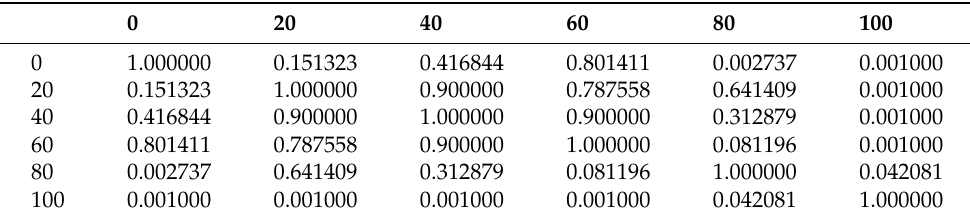
Table 5. Multiple Comparison Test (Tukey’s method) performed on clogging level groups from Airflow CH2